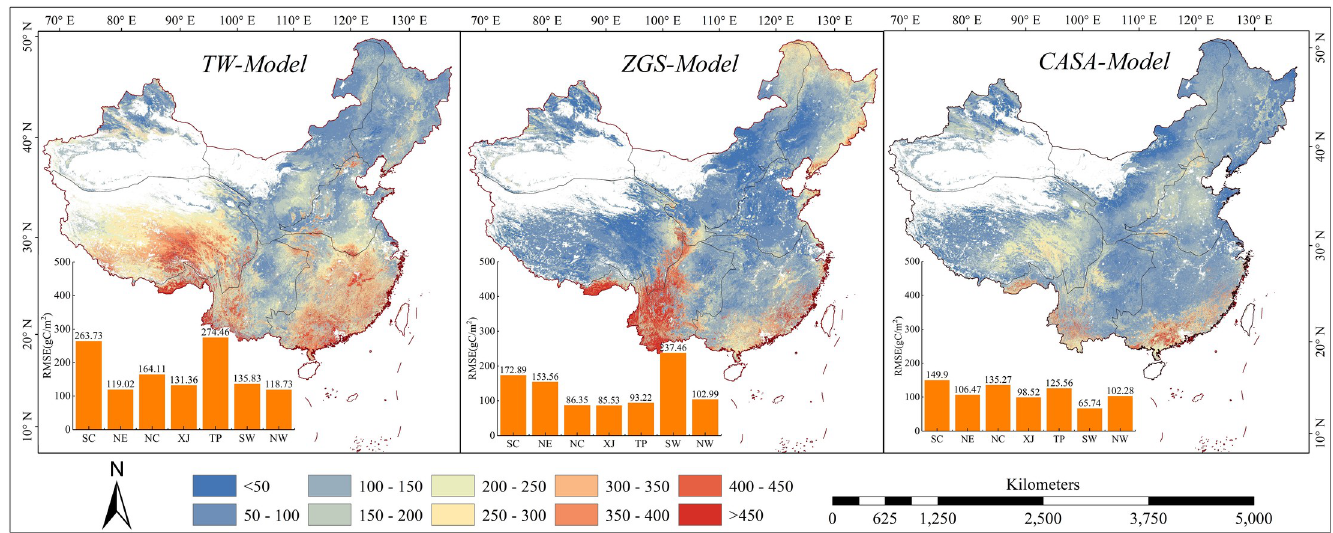
Fig 7. The spatial distribution of RMSE of three models compared with MODIS NPP product.